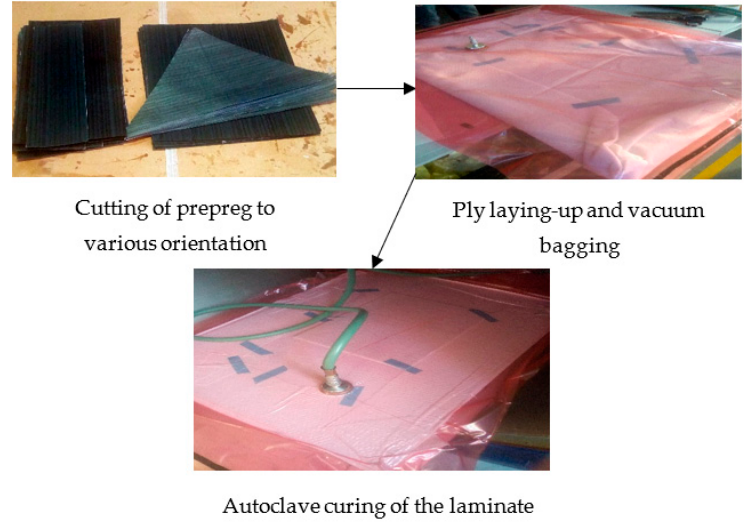
Figure 1. The autoclave manufacturing process of CFRP Laminate.